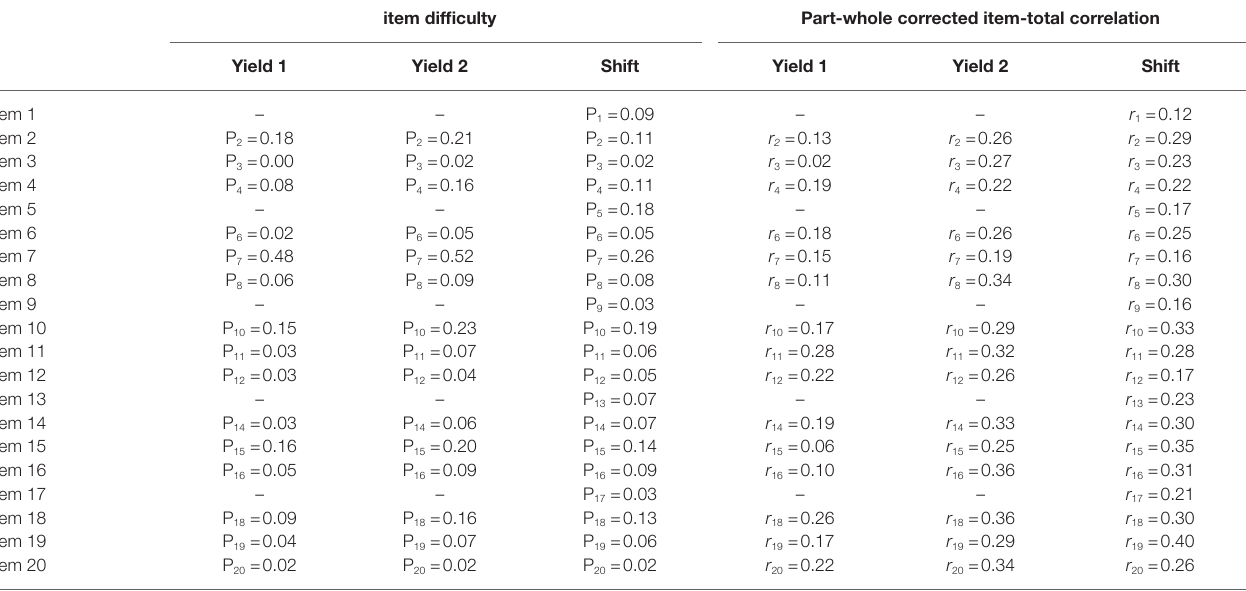
TABLE 1 | Item difficulty and part-whole corrected item-total correlation for calculated Yield and Shift Items (values from 0 to 1). The sequence of the numbered items corresponds exactly to the numbered item sequence in the English GSS 1. item